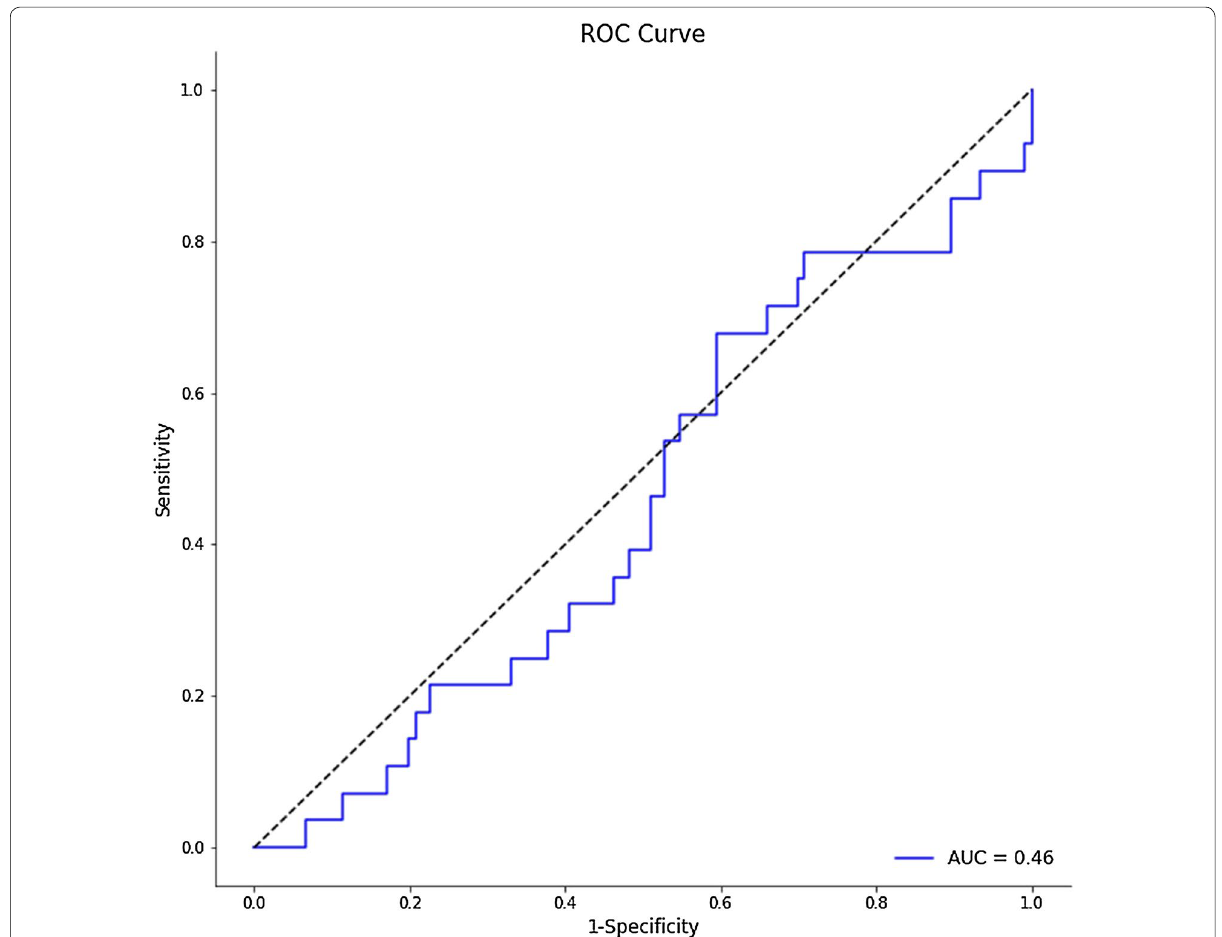
Fig. 3 The ROC curve for the deep neural networks in the testing dataset. AUC